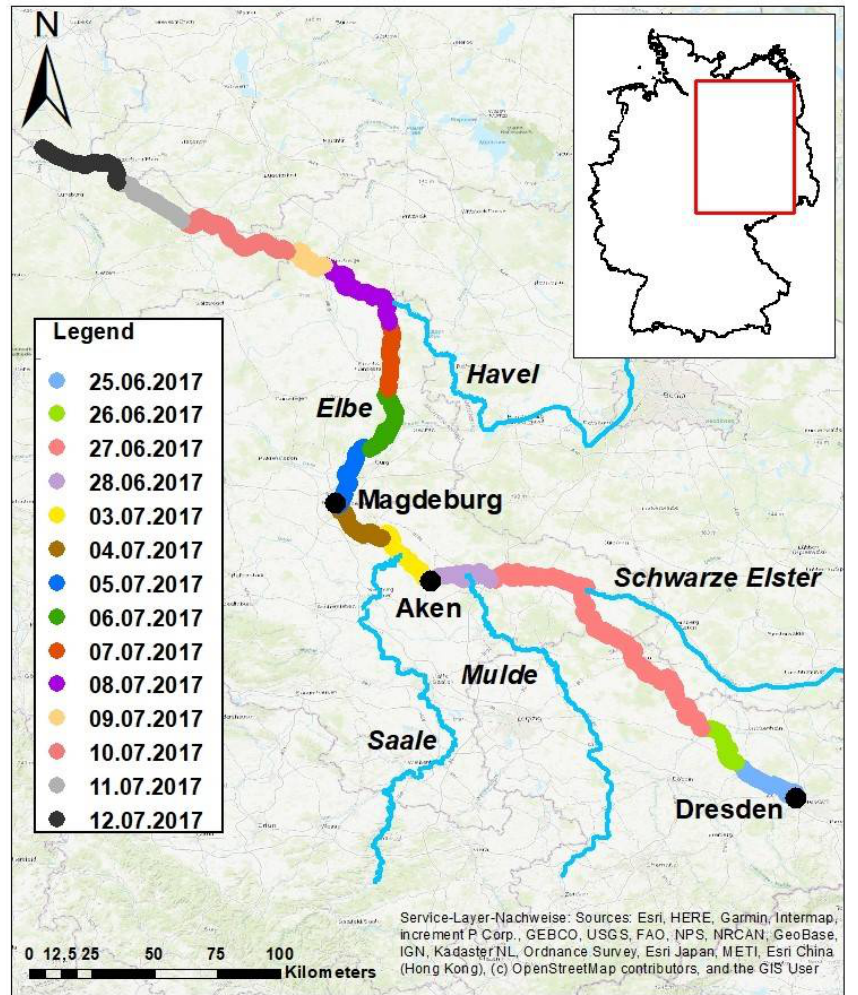
Figure 1. The investigated stretch of the Elbe River and major tributaries. Individual stages of the survey are colored according to date. The survey took place from 25 June 2017 to 12 July 2017. The survey covered a 550 km long stretch of the Elbe River from Dresden downstream to Geesthacht.